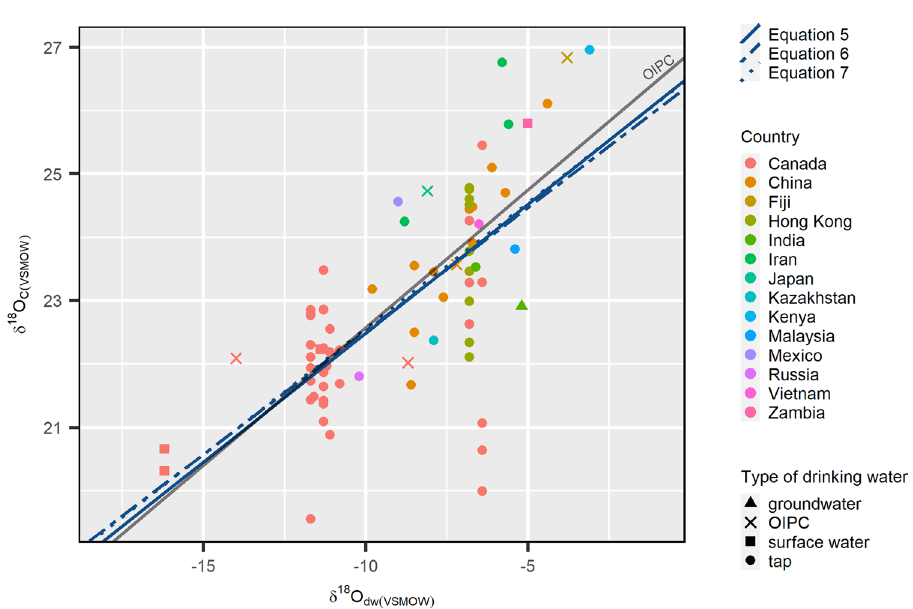
Figure 10. The relationships between δ 18 O c(VSMOW) and δ 18 O dw values are shown for all sampled individuals (n = 75). Colours indicate the country of residence, and shapes indicate the type of drinking water sampled for its δ 18 O dw value. The different line types show the regression line between δ 18 O c and δ 18 O tap values for Eq. (5): δ 18 O c(VSMOW) = 0.11 (± 0.09) x δ 18 O tap(VSMOW) + 23.29 (± 0.98); [df = 32; R 2 = 0.01], δ 18 O dw values including both tap and surface water values for Eq. (6): δ 18 O c(VSMOW) = 0.16 (± 0.08) × δ 18 O dw_1(VSMOW) + 23.77 (± 0.82); [df = 35; R 2 = 0.09] and δ 18 O 18 O 18 O dw values for all samples for Eq. (7): δ c(VSMOW) = 0.15 (± 0.07) x δ dw_2(VSMOW) + 23.65 (± 0.78); [df = 37; R 2 = 0.08]. The solid grey line represents the regression line between δ 18 O c and δ 18 O OIPC values; Eq. (8): δ 18 O c(VSMOW) = 0.43 (± 0.05) × δ 18 O OIPC(VSMOW) + 26.92 (± 0.46); [df = 73, R 2 =